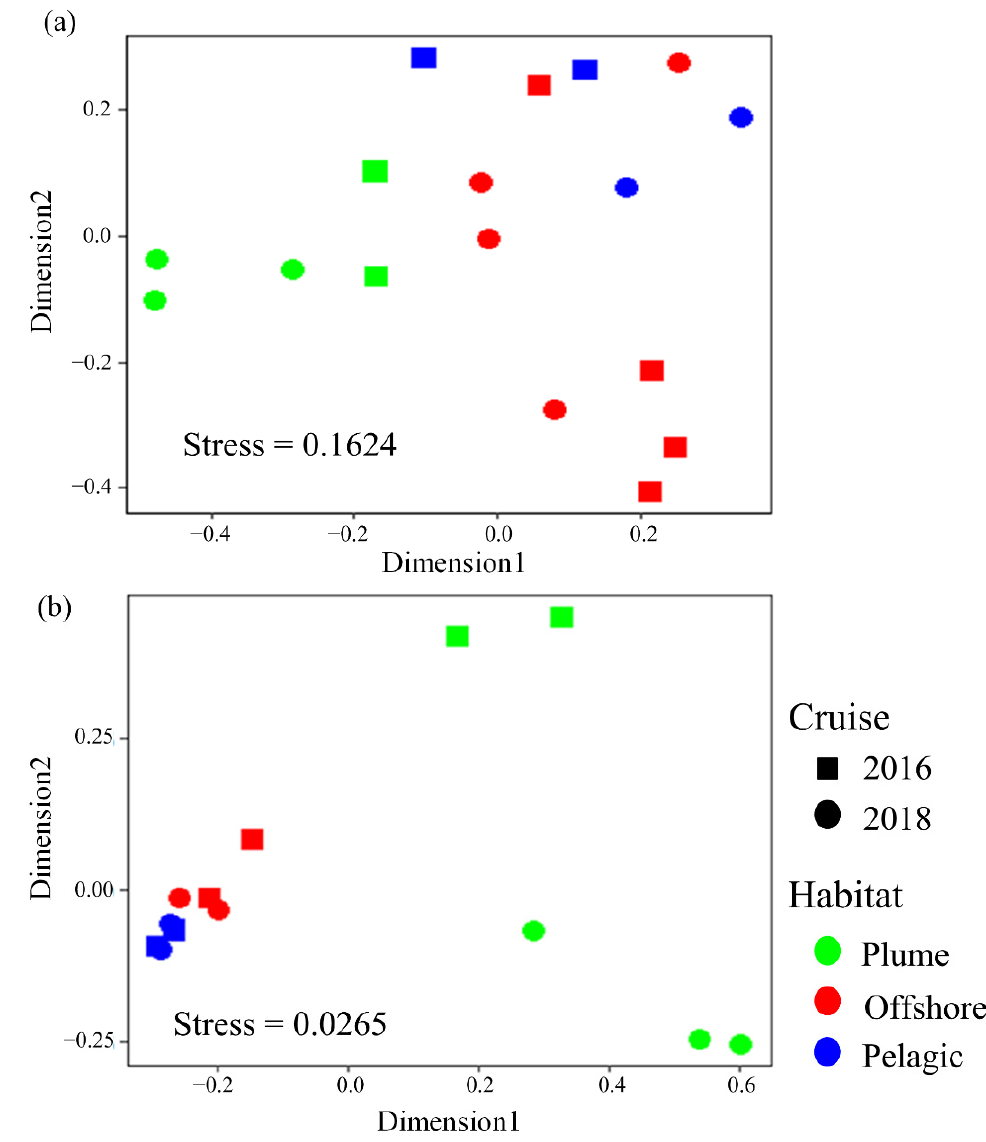
Figure 4. LP community variations across salinity gradient: ( a ) MDS analysis of LP communities; ( b ) MDS analysis of bacterioplankton. Different colors were used to distinguish the sampling habitats. Plume, Offshore and Pelagic were marked in green, red and blue, respectively.